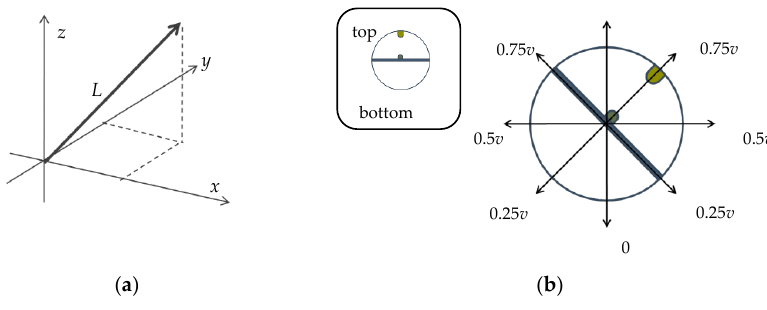
Figure 5. Volume control: ( a ) Vector length; ( b ) Static case.